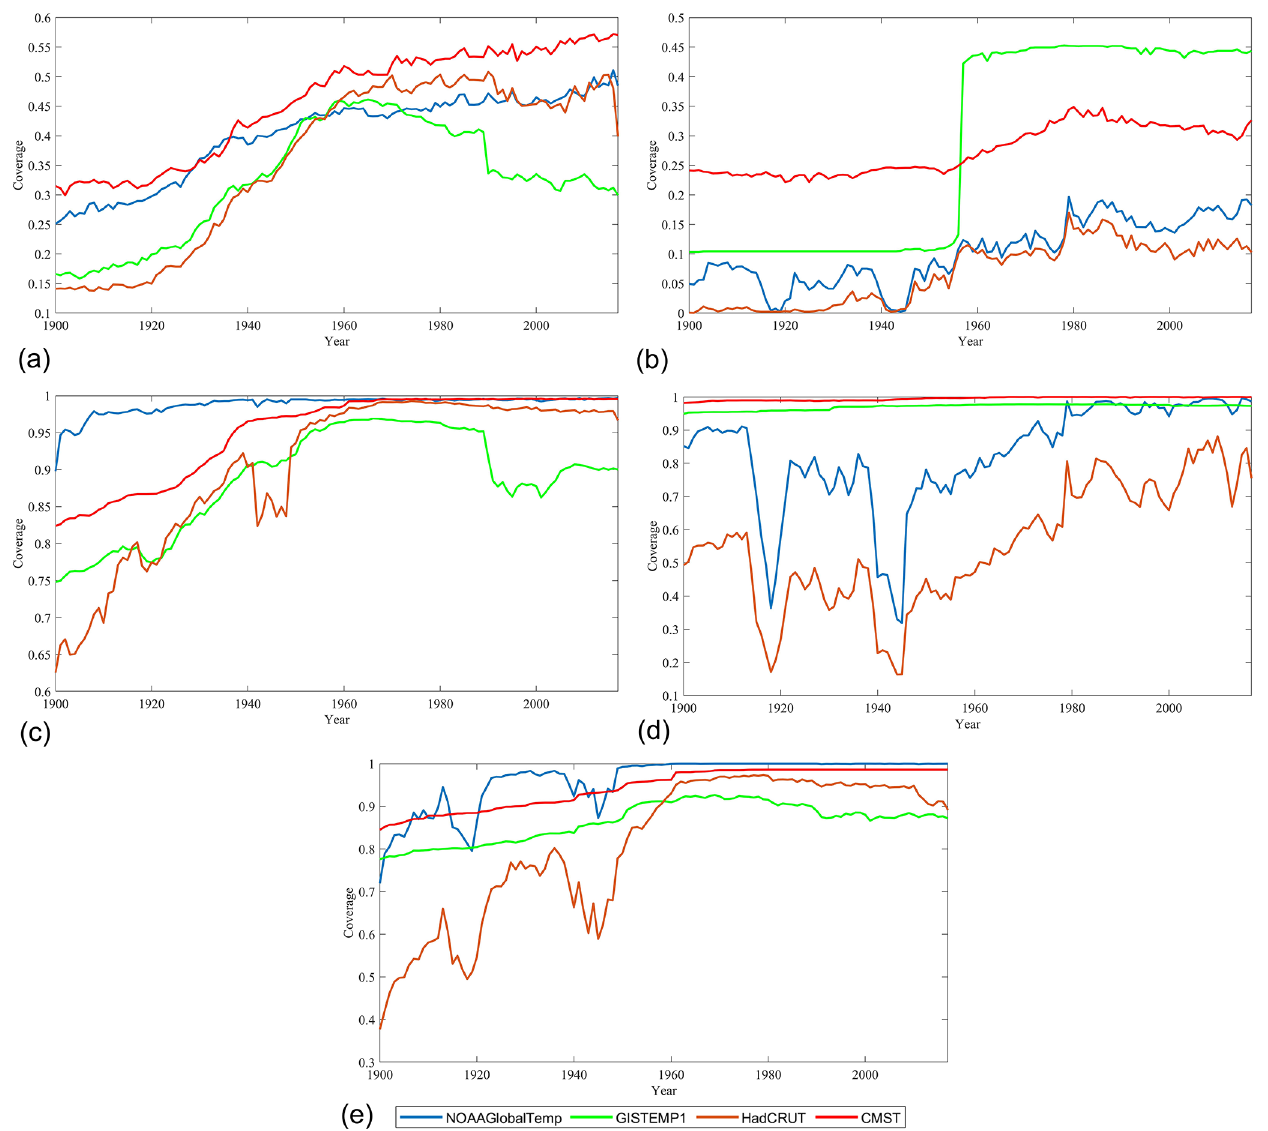
Figure 7. Comparison of the annual averages of ST dataset coverage for each latitude zone between 1900 and 2017 in (a) 90–60 ◦